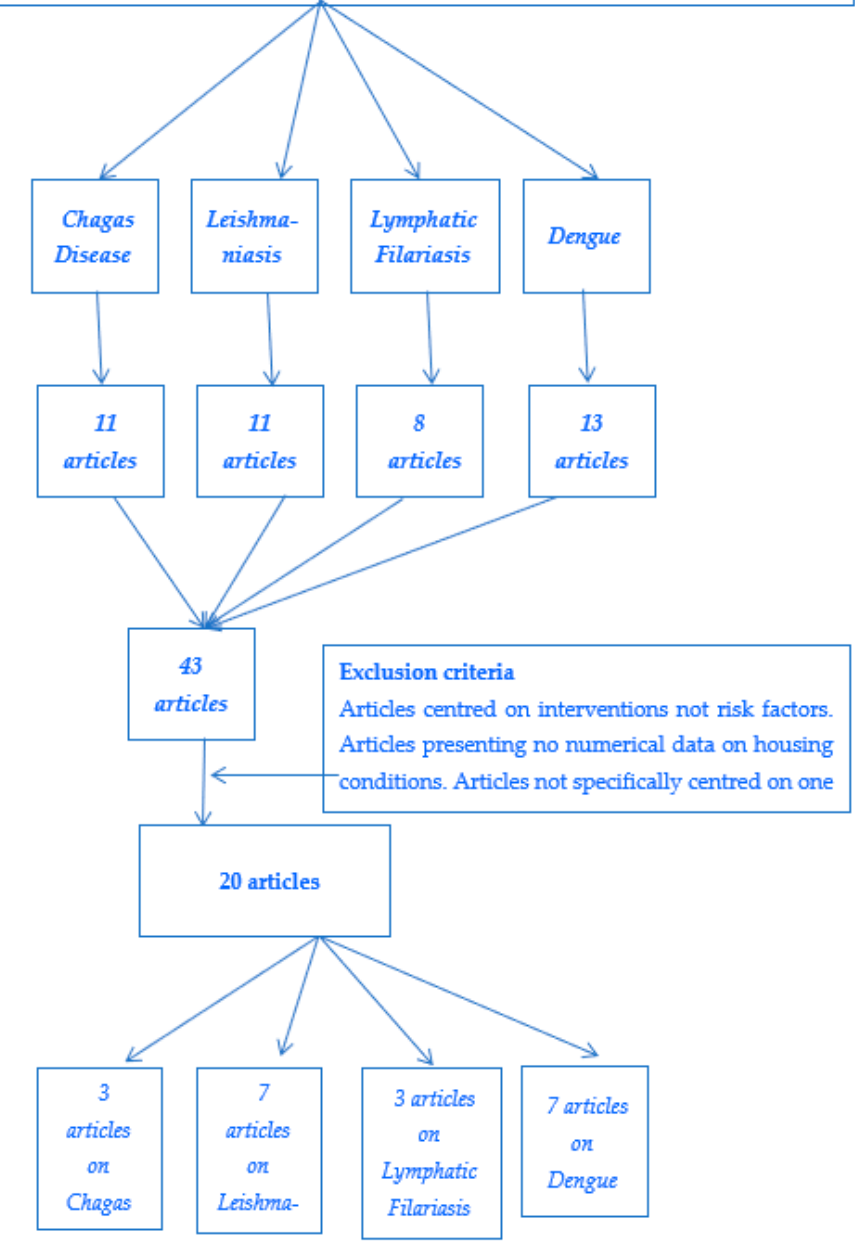
Figure 1. Research strategy (limited to PubMed) and results.